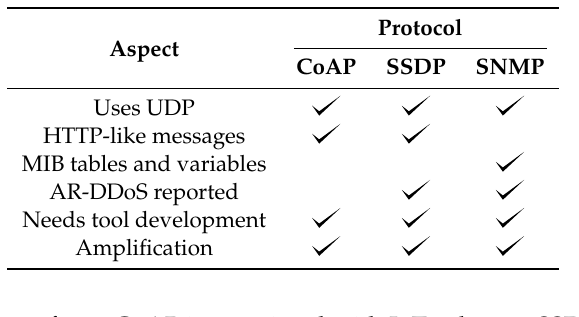
Table 6. Candidate protocol